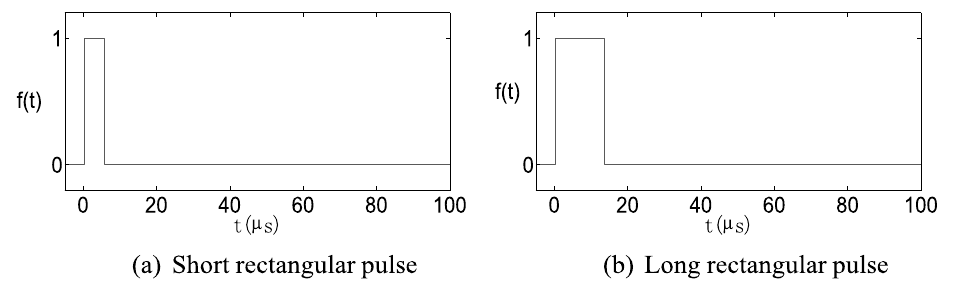
Fig. 5. Relative errors in the cross section area identi fi cation for Case 2, fi rst and second parts.